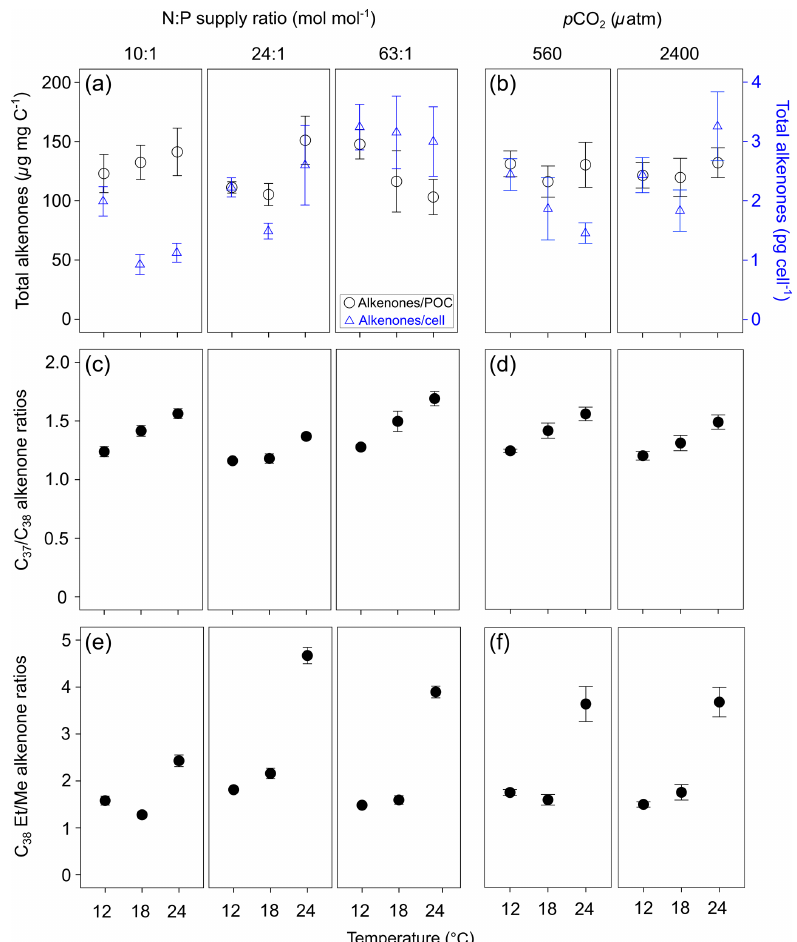
Figure 2. Carbon-normalized (open circles) and per-cell (open triangles) contents of C 37 –C 39 total alkenones (mean ± SE; µgmgC − 1 and pgcell − 1 , respectively) (a, b) , C 37 / C 38 alkenone ratios (c, d) and C 38 ethyl / C 38 methyl ratios (C 38 Et / Me alkenone ratios) (e, f) in Emiliania huxleyi in response to the changes in temperature, N:P supply ratios and p CO 2 . Triplicates were set for each